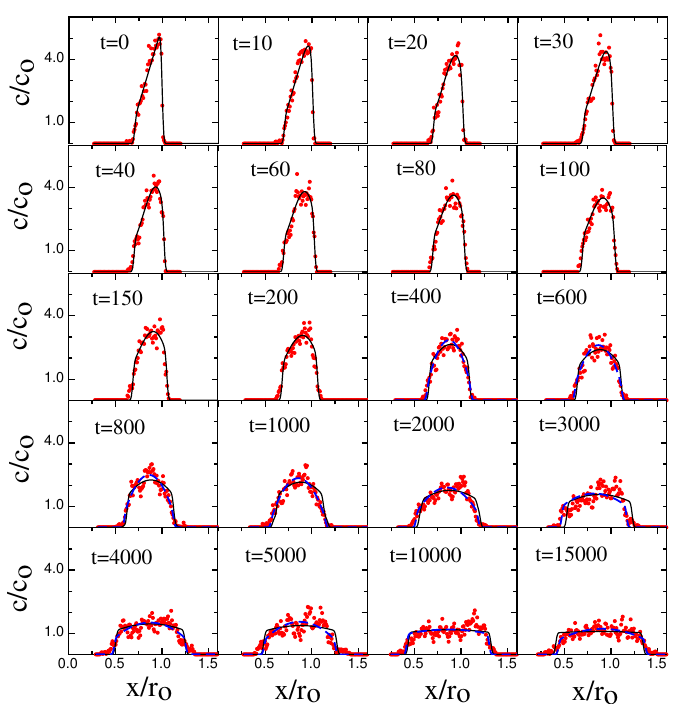
Figure 6. Time evolution of the normalized chain density c ( x , t ) / c 0 along the channel axis during bead retraction. The channel width D = 16 and the persistence length L p = 2.5. The chain profile is compressed by moving the gasket at a sliding speed V push = 0.05; the bead is then retracted at speed V retract = 4 V push , inducing relaxation of the profile. Time-values are shown in snapshot units, with one snapshot corresponding to 1000 iterations. The red circles correspond to the BD simulation data; the black solid lines correspond to the fitted prediction from the NPDE model. The dashed blue curves for t > 400 correspond to fits to a parabolic concentration model. The NPDE model is solved with a D o = 0.74 (obtained from the ramp-slope in steady-state); this D o value leads to a τ = 75,000. The best-fit β = 0.26. The value of σ = 0.013 r o , determined from a fit of a broadened ramp profile model to the profile at t =